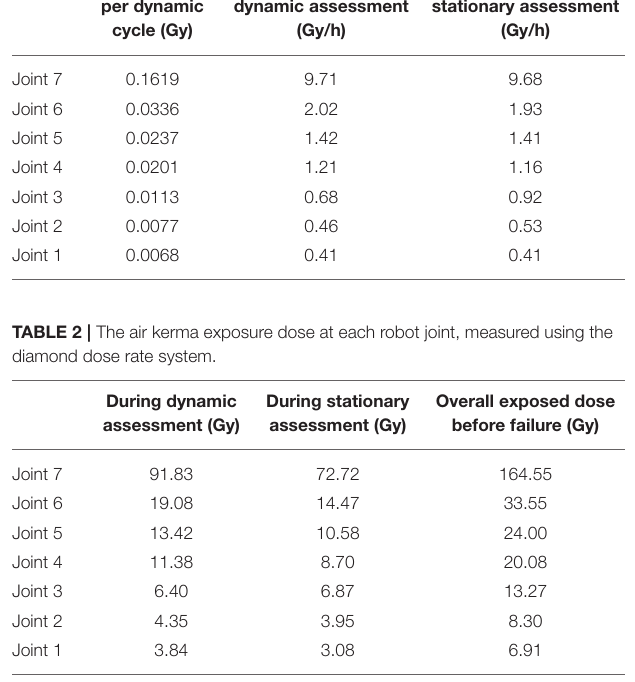
TABLE 1 | The air kerma exposure dose-rate at each robot joint, measured using the diamond dose rate system. Dose rate during Dose rate during Exposed dose stationary assessment dynamic assessment per dynamic